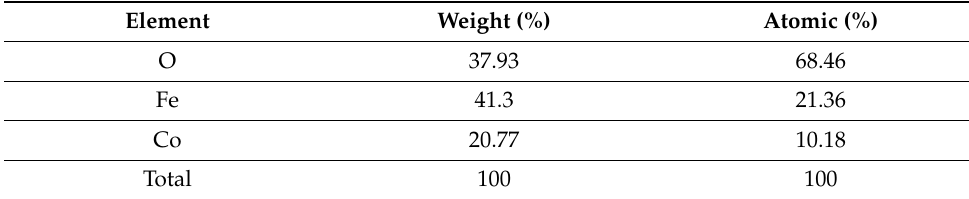
Table 1. EDS for % elemental composition of CoFe 2 O 4 nanoparticles prepared at 180 ◦ C, 16 h.